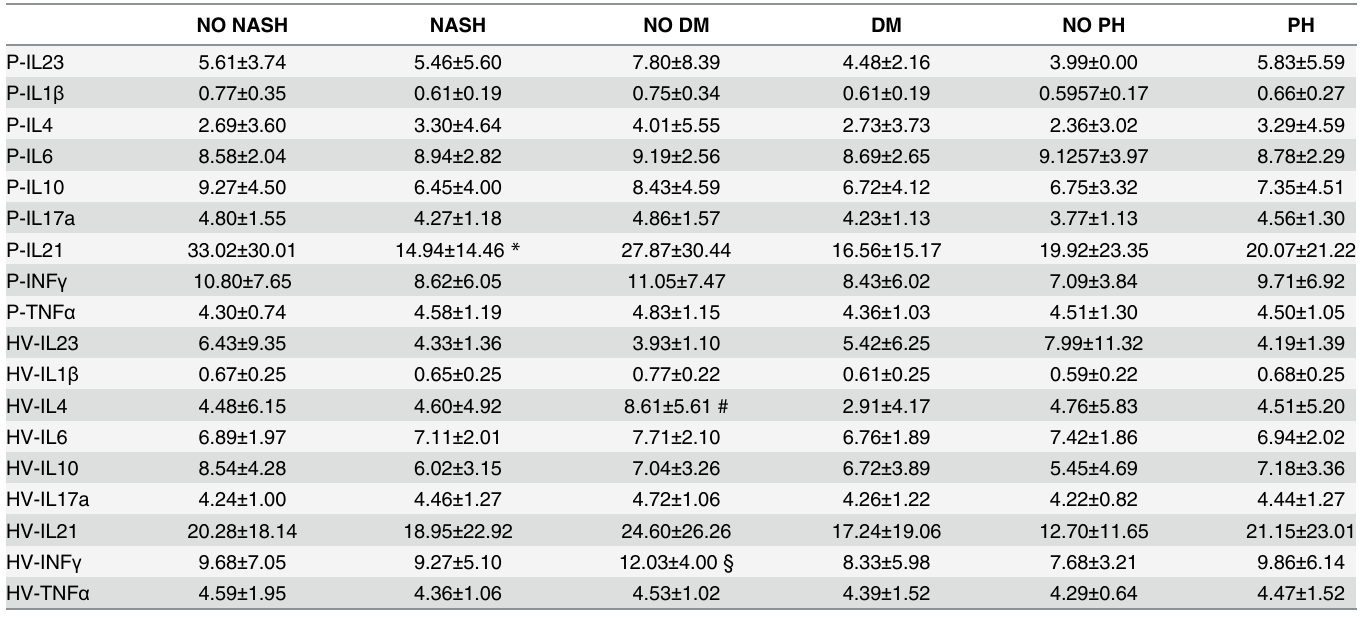
Table 4. Cytokine levels in different groups of patients.